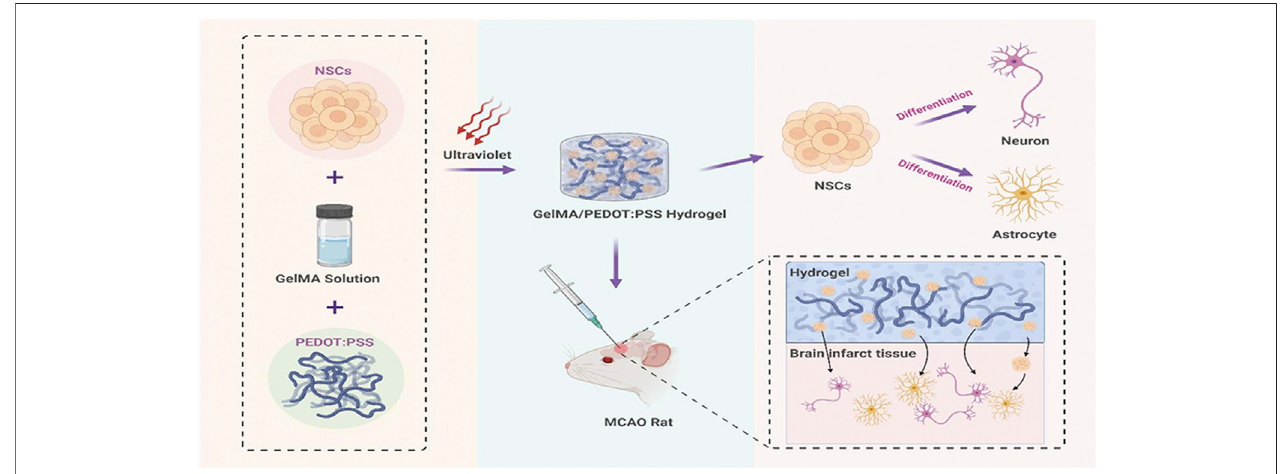
FIGURE 1 | Scheme. Conductive GelMA/PEDOT:PSS hybrid hydrogel to promote NSCs differentiation and treat cerebral I/R